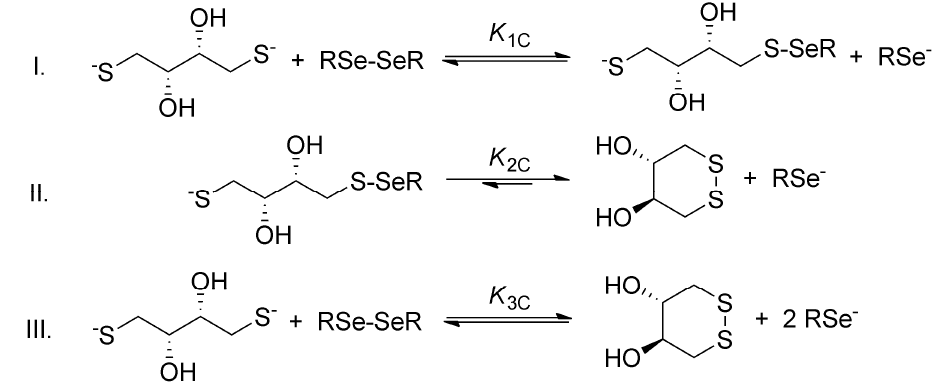
Figure 2. The redox reaction between oxidized glutathione and dithiothreitol (DTT) 2 − dominant microspecies at the pH of blood.